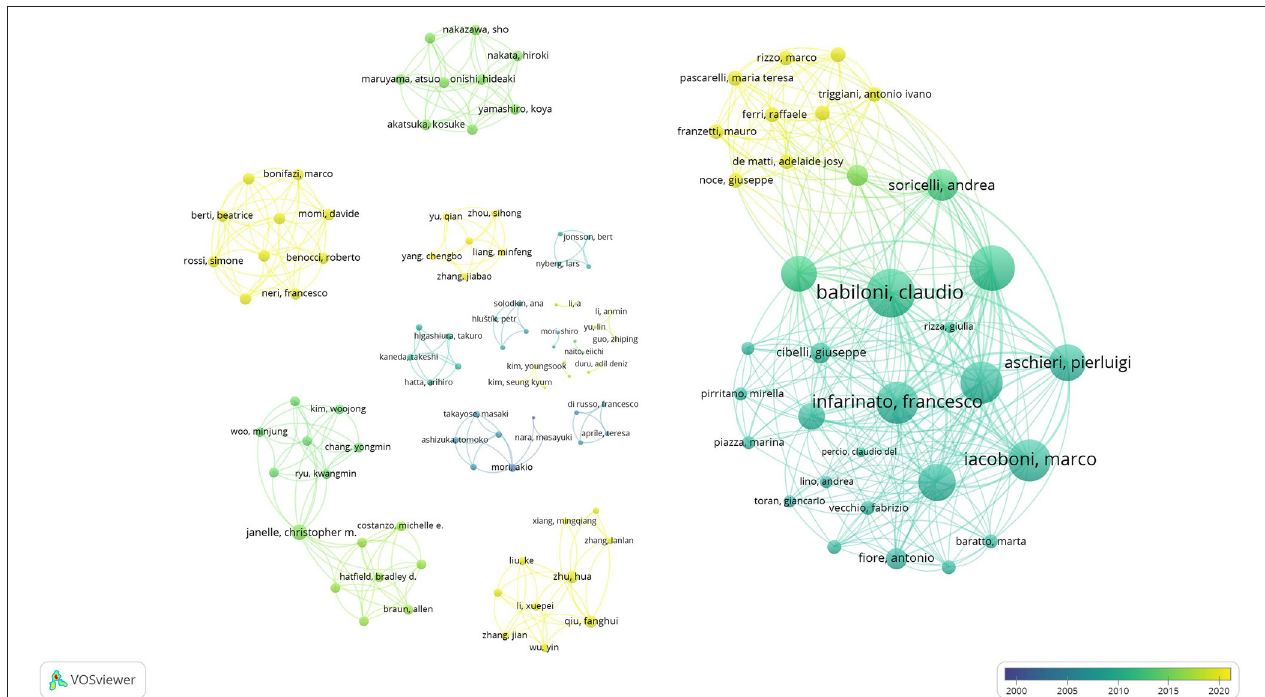
FIGURE 3 | Co-authorship map.